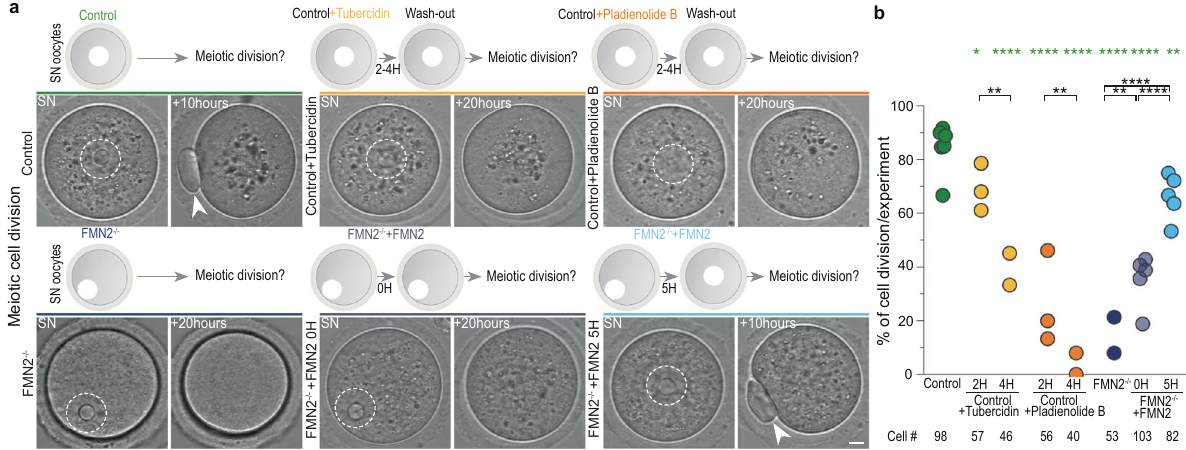
Fig. 5| Cytoplasmicforce-basedregulationofmRNAprocessing drivesmeiotic cell division. a Assessment of the fi rst meiotic division in Control, Control+ Tubercidin, Control+Pladienolide B, FMN2 − / − , FMN2 − / − +FMN2 0-h and 5-h rescue contexts;time-lapseimages of ProphaseSNstage oocytes6minpriortoentryinto division, measured by nuclear envelope breakdown, and 10 to 20h after nuclear envelopebreakdownwithillustrationsof eachapproachabove;nucleiareoutlined in dashed white; arrowheads indicate the extruded polar body, a readout of